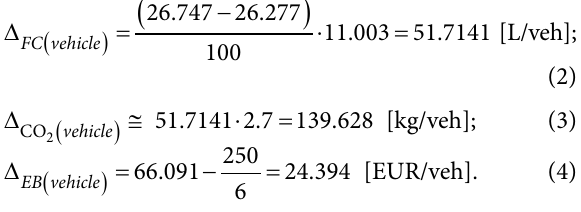
Table 5. Empirical and theoretical values of average FC in the overall observation period with average ambient temperature